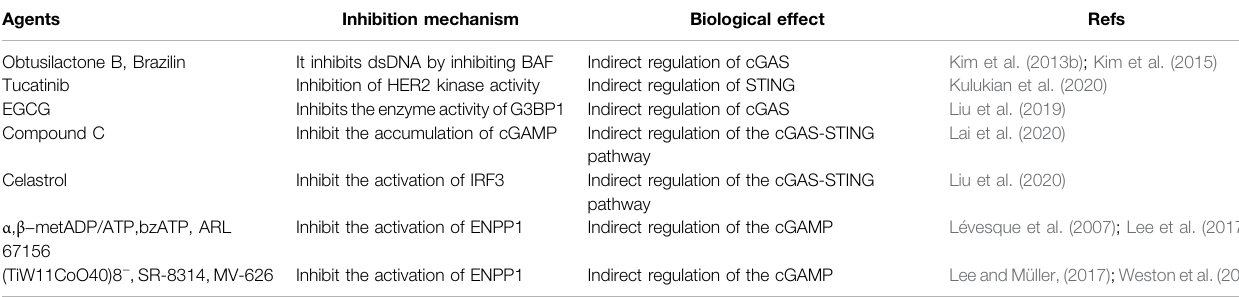
TABLE 4 | Indirect regulators targeting the cGAS-STING